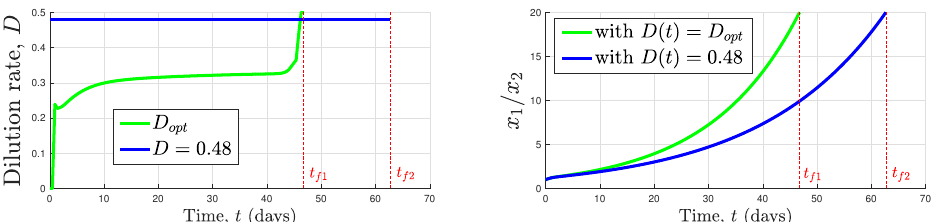
Figure 2. It is possible to find a constant feeding strategy D ∈ [ 0, D max ] that could favor one species or the other. However, this is a risky time-consuming process, while the target is reached much faster using an optimized control D opt , thus saving several days of costly